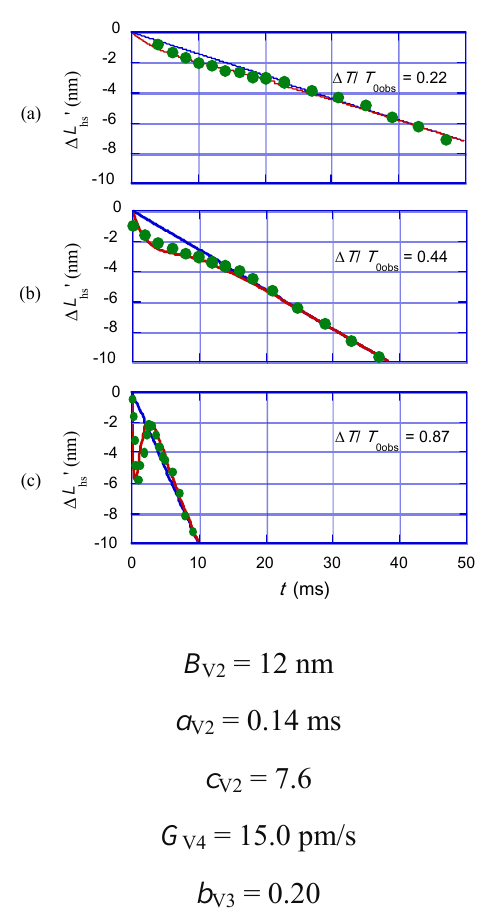
= ( T − T )/ T 0obs 0obs 0obs